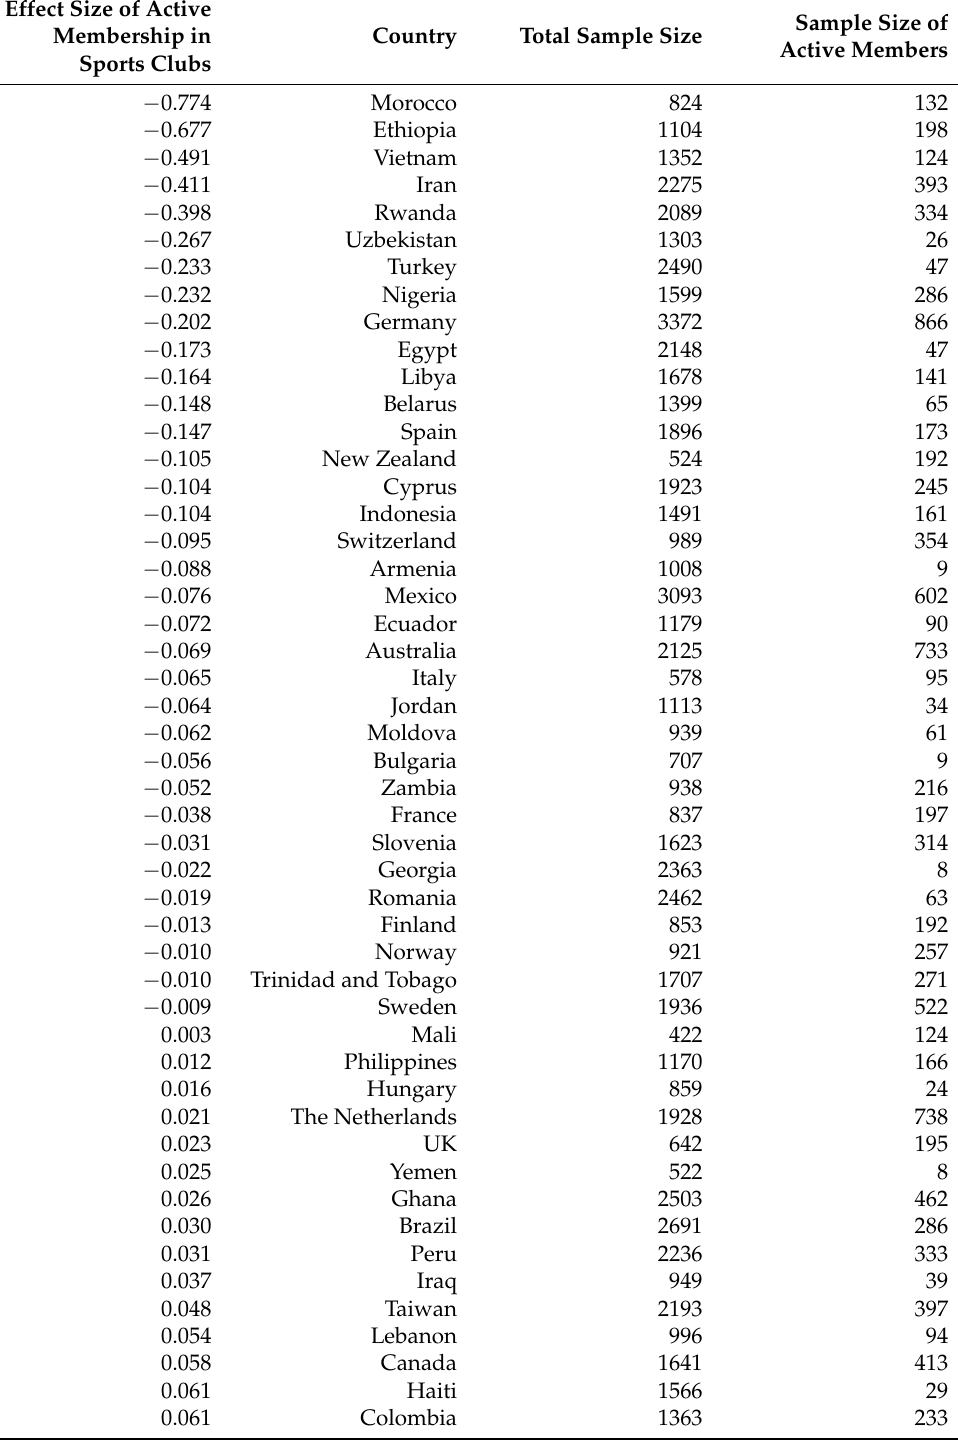
Table A7. List of country-specific effects for active membership in sports clubs on sexist gender ideologies for the group of women. Source: WVS-EVS